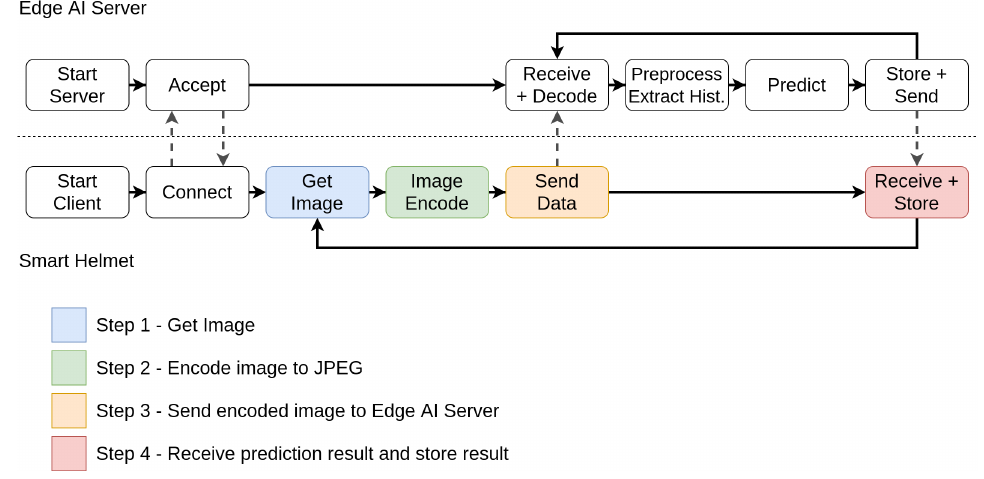
Figure 23. Stages considered in the architectural validation test.